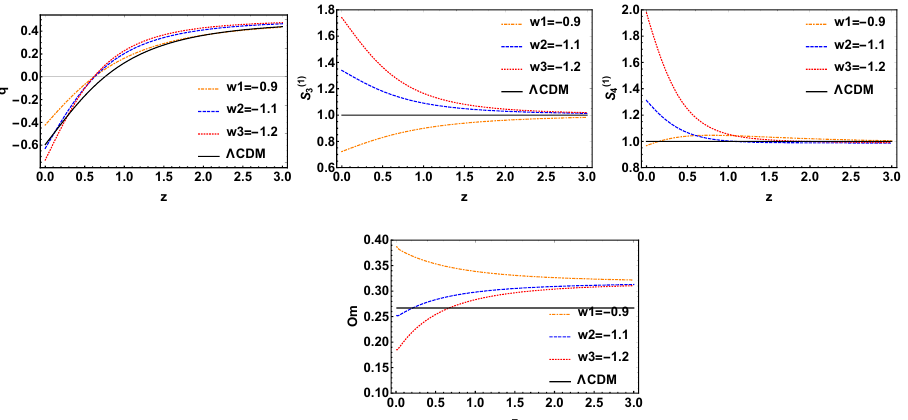
( 1 ) ( 1 ) , S and Om , respectively, versus red shift z for the 3 4